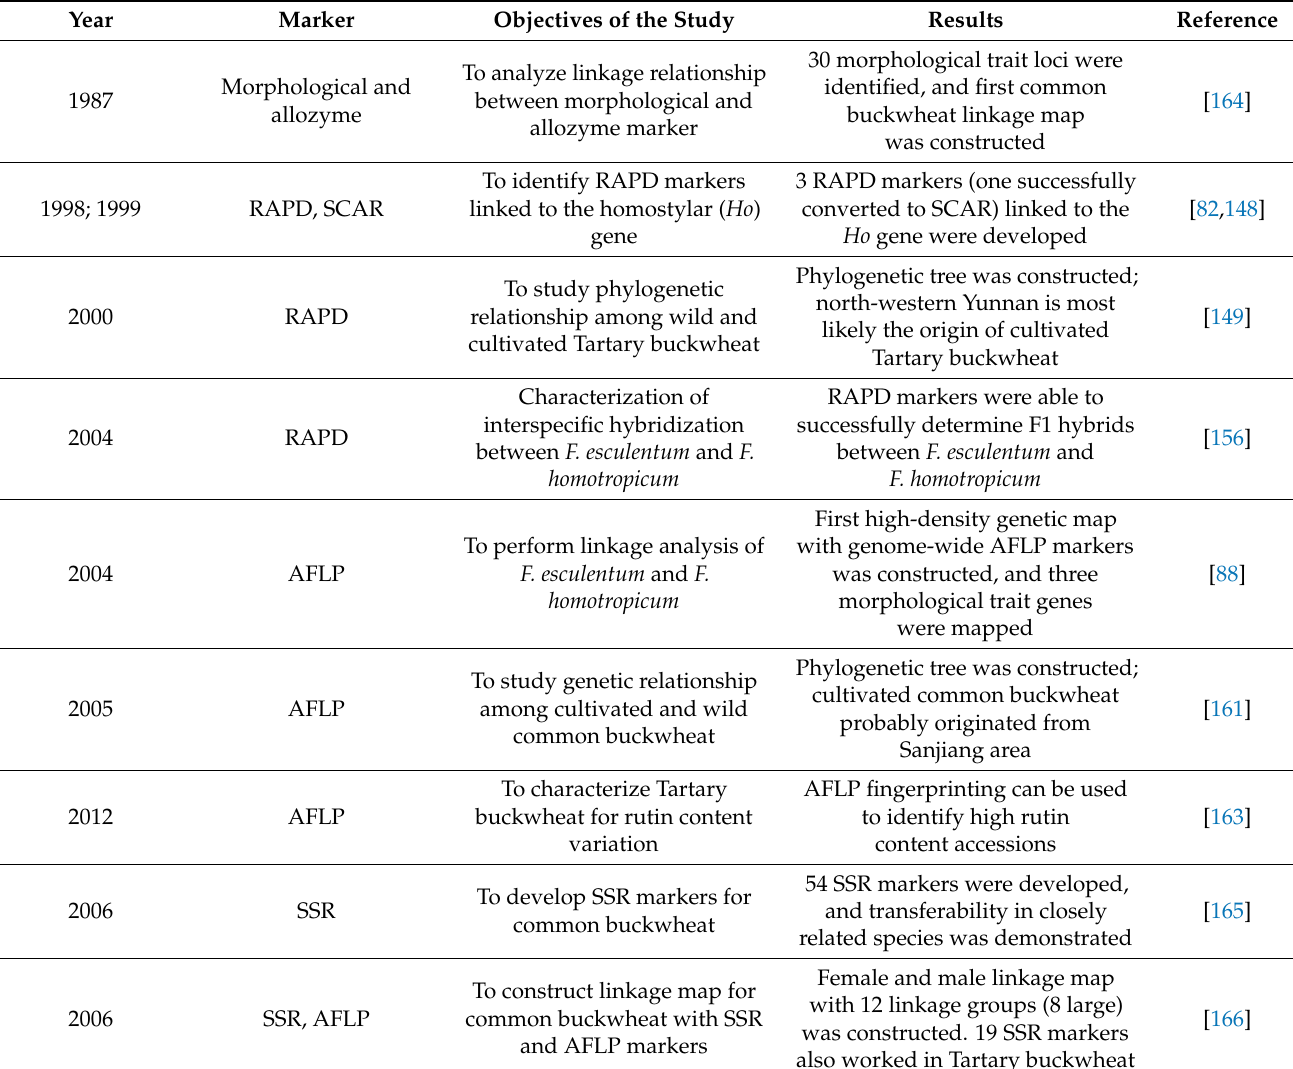
Table 2. Groups of markers used for genomic studies of the genus Fagopyrum